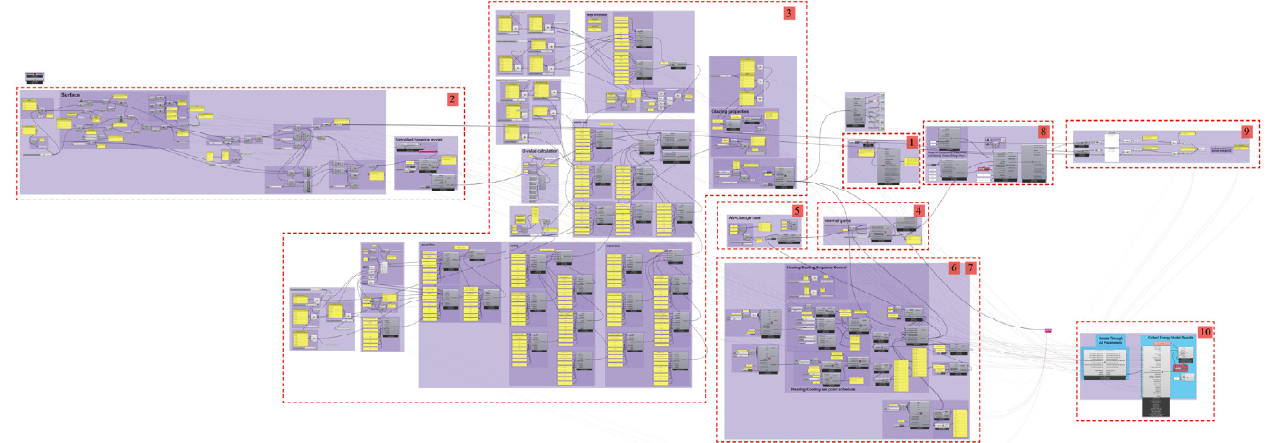
Figure 15. Process description of Grasshopper.